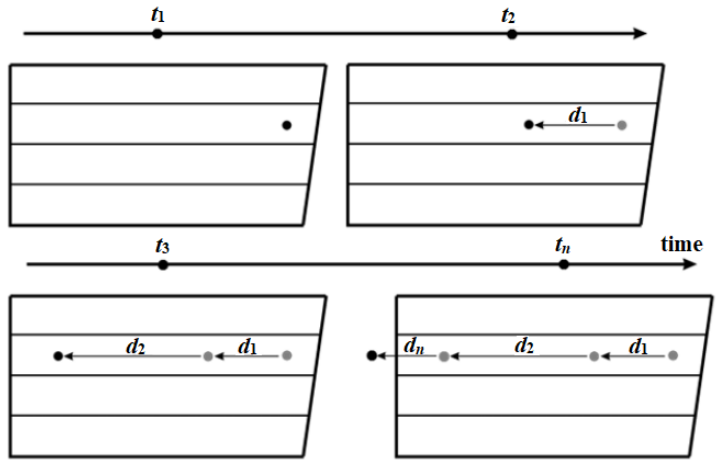
Figure 4. Transportation of vehicle screen coordinates into geographic coordinates using perspective transformation.